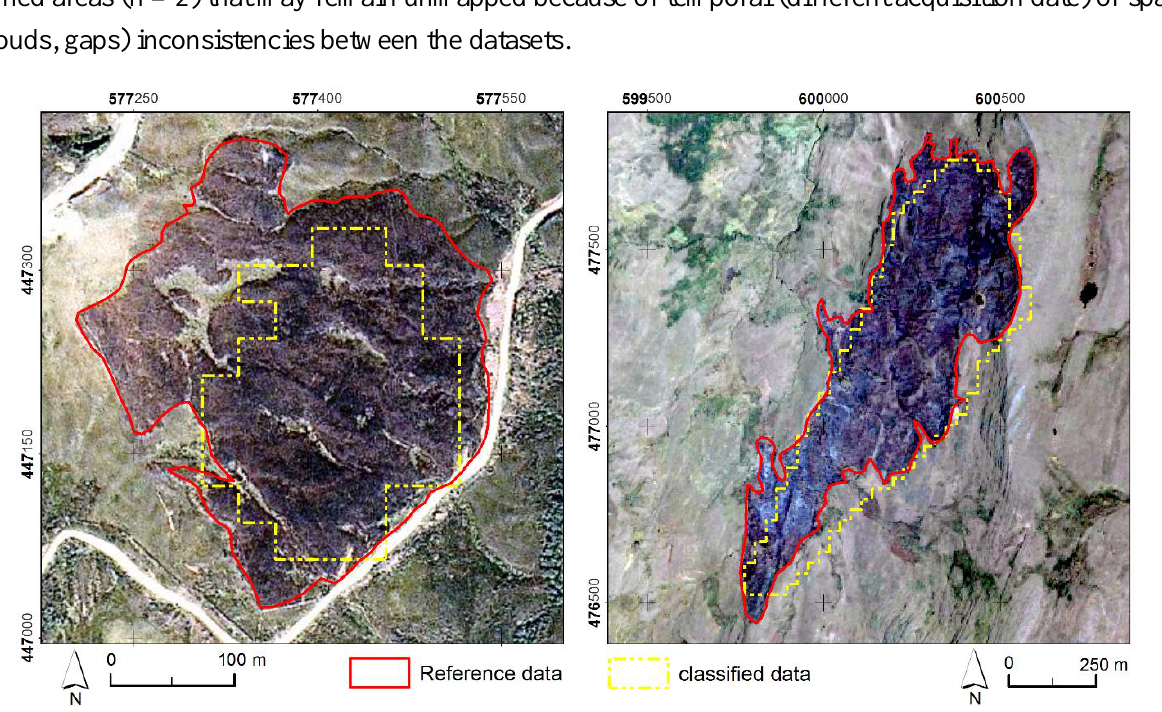
Figure 6. Examples of the dataset used during the accuracy assessment analysis.